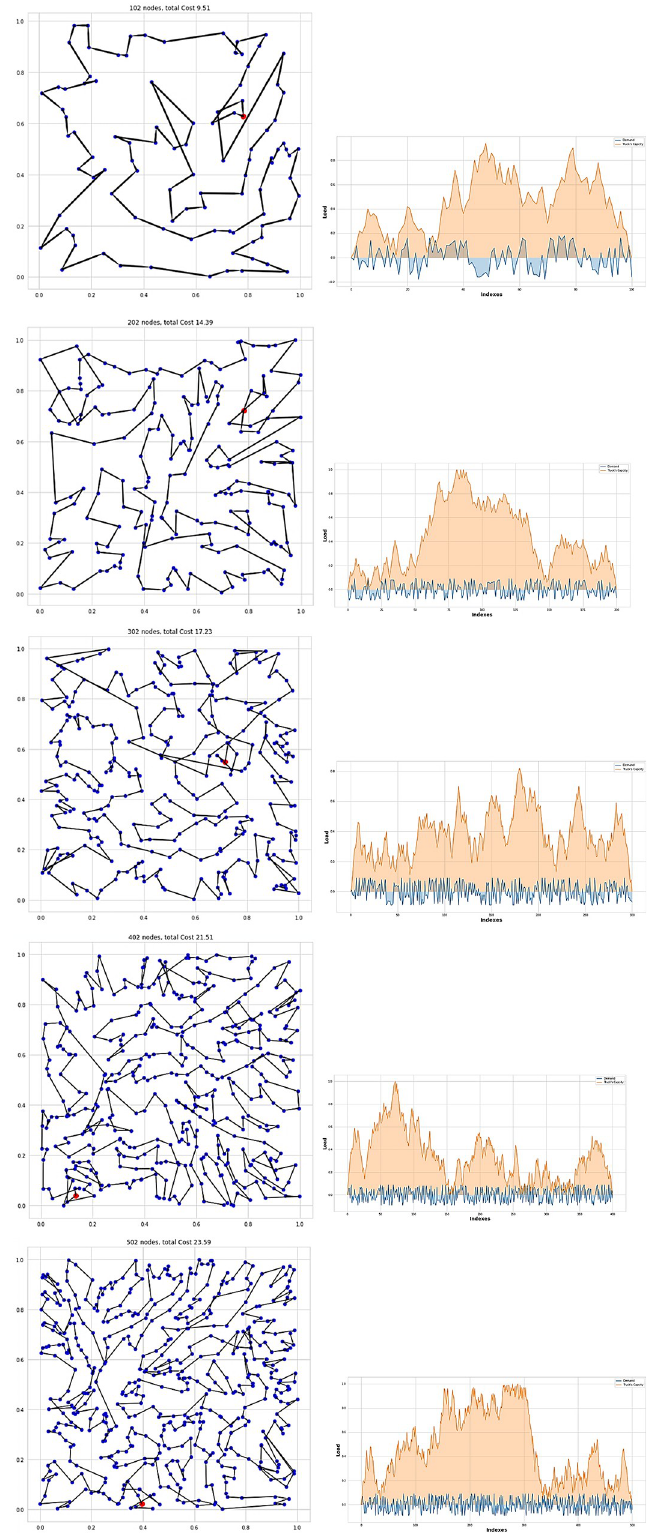
Fig 6. Sample tour for BBS101, BBS201, BBS301, BBS401 and